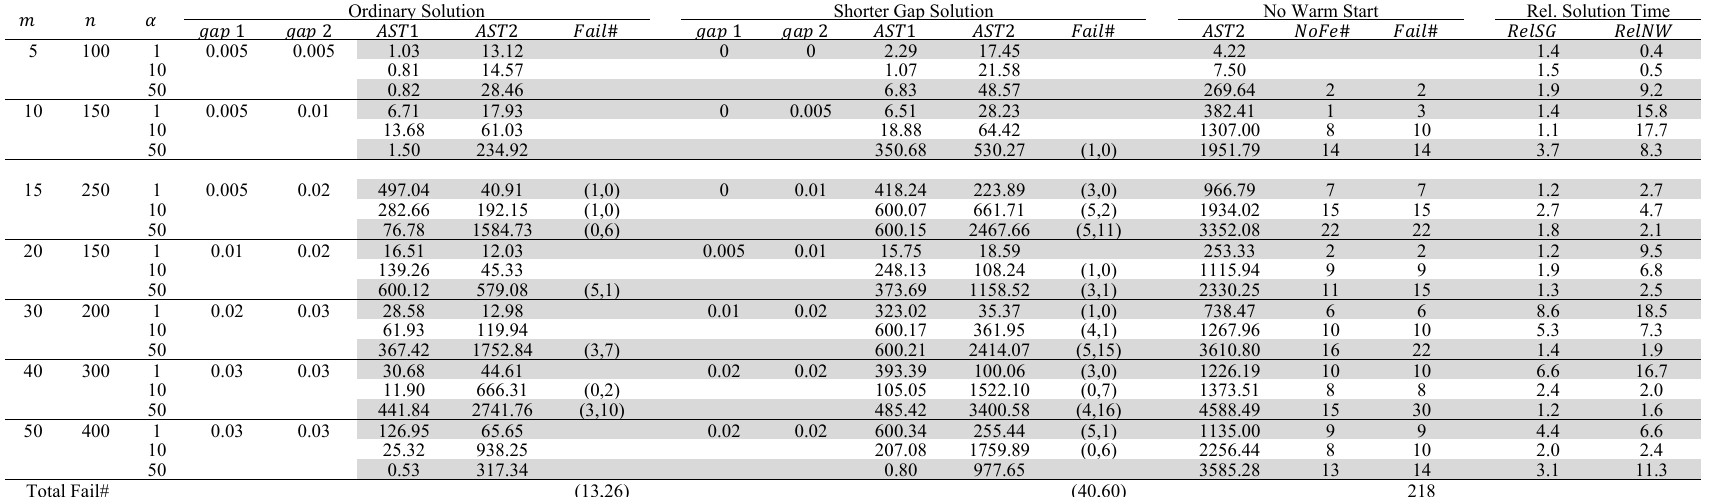
Results for the evaluation of the solution reduction time strategies in the MILP solution approach